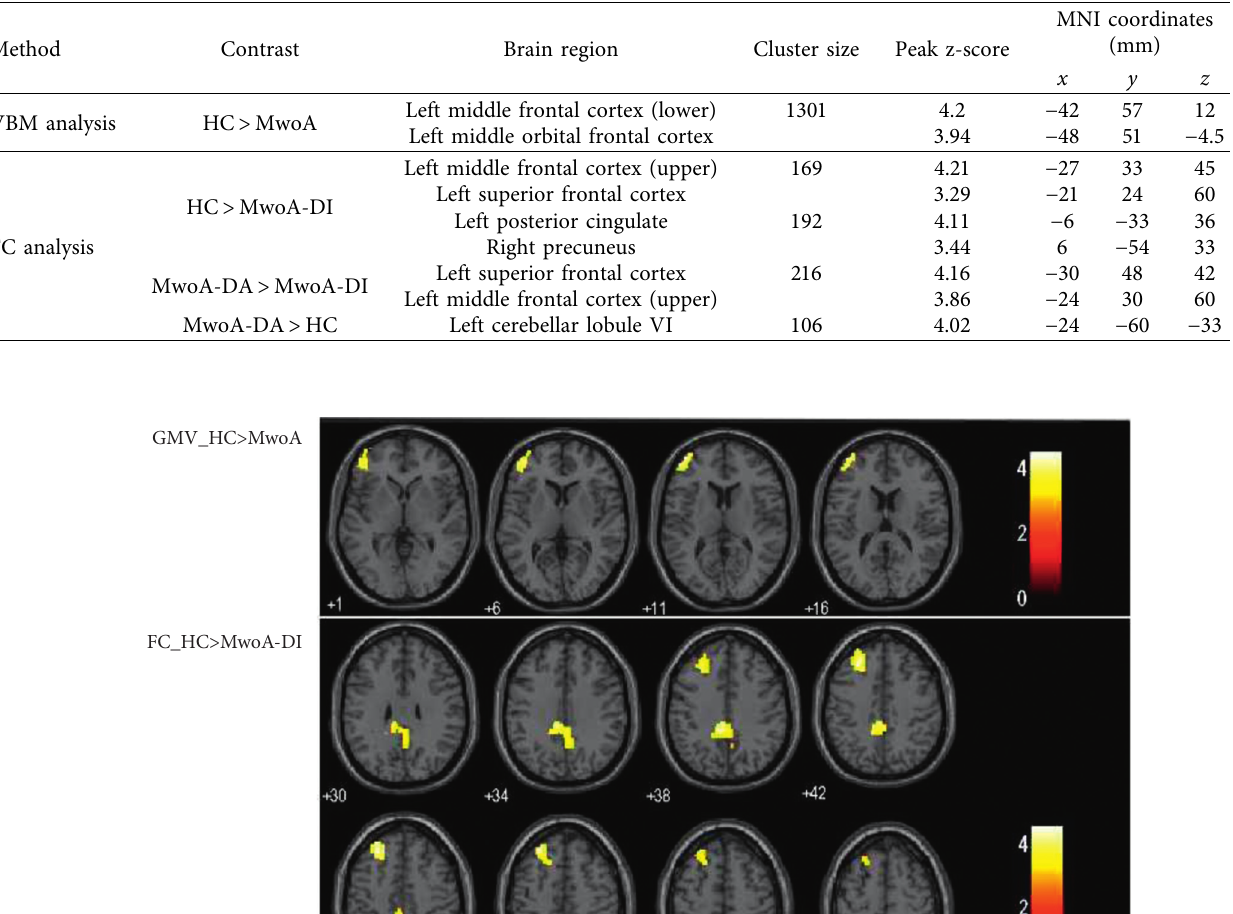
Table 2: VBM results and functional connectivity results using the VBM cluster as the seed between three groups.